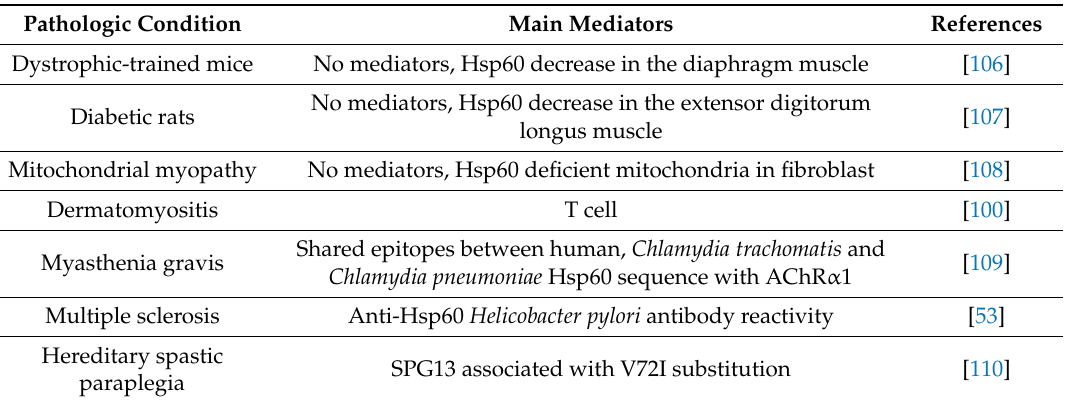
Table 1. Hsp60 and skeletal muscle